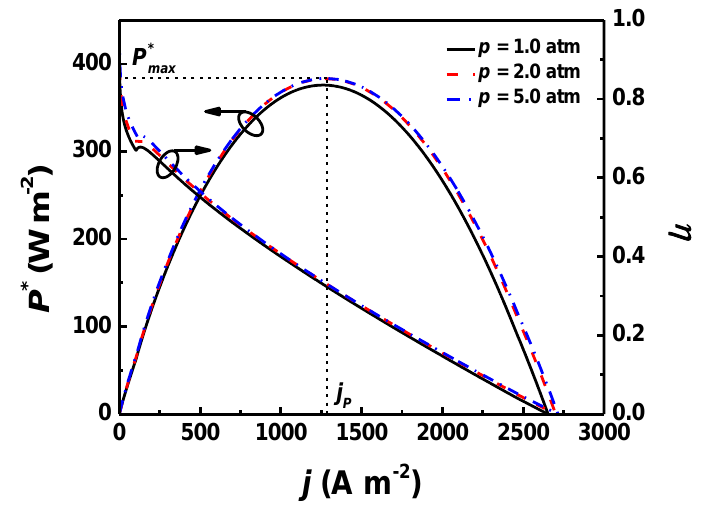
p on the hybrid system performance. Figure 7. Effects of operating pressure